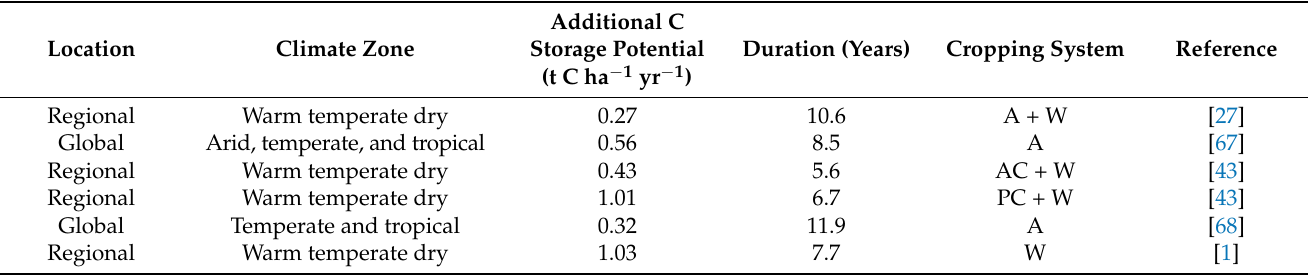
Table 3. Summary of meta-analyses assessing SOC sequestration rates in different locations and climatic zones. Authors’ elaboration published in